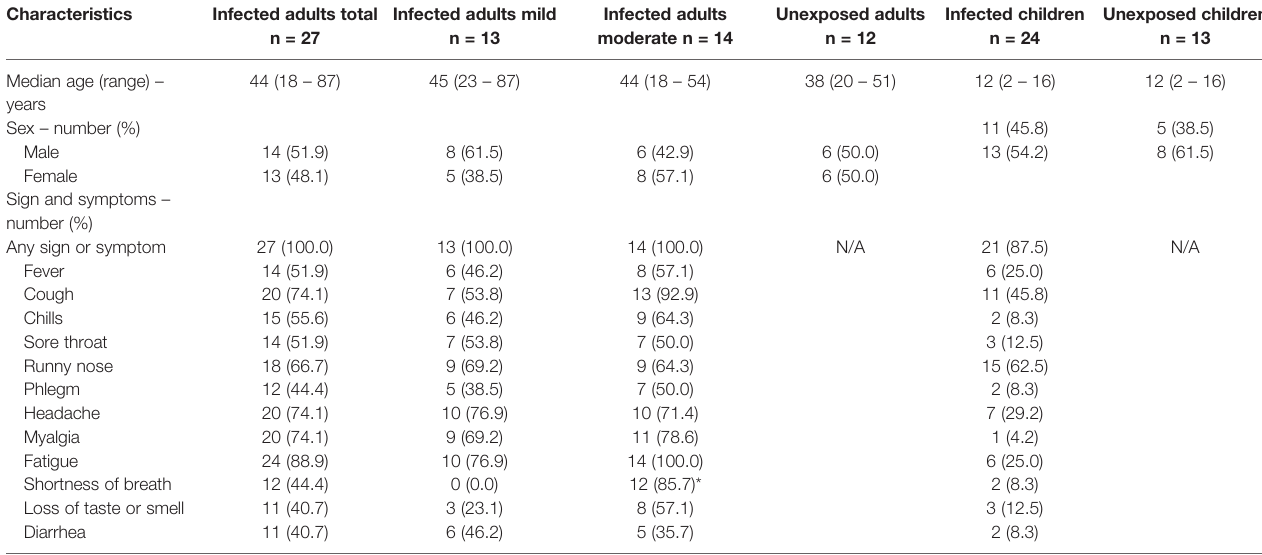
TABLE 1 | Demographic and clinical characteristics of adults (with mild versus moderate symptoms) and children with PCR con fi rmed SARS-CoV-2 infection and demographic data of unexposed participants.